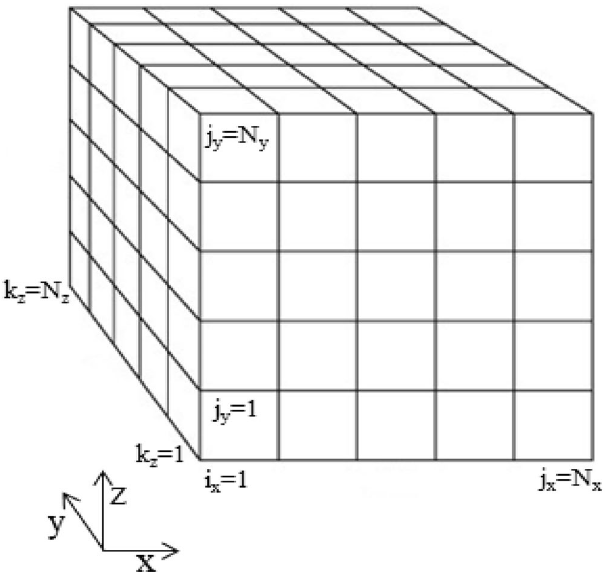
Figure 6. Regular three-dimensional grid consisting of necks with regular polygonal cross section.